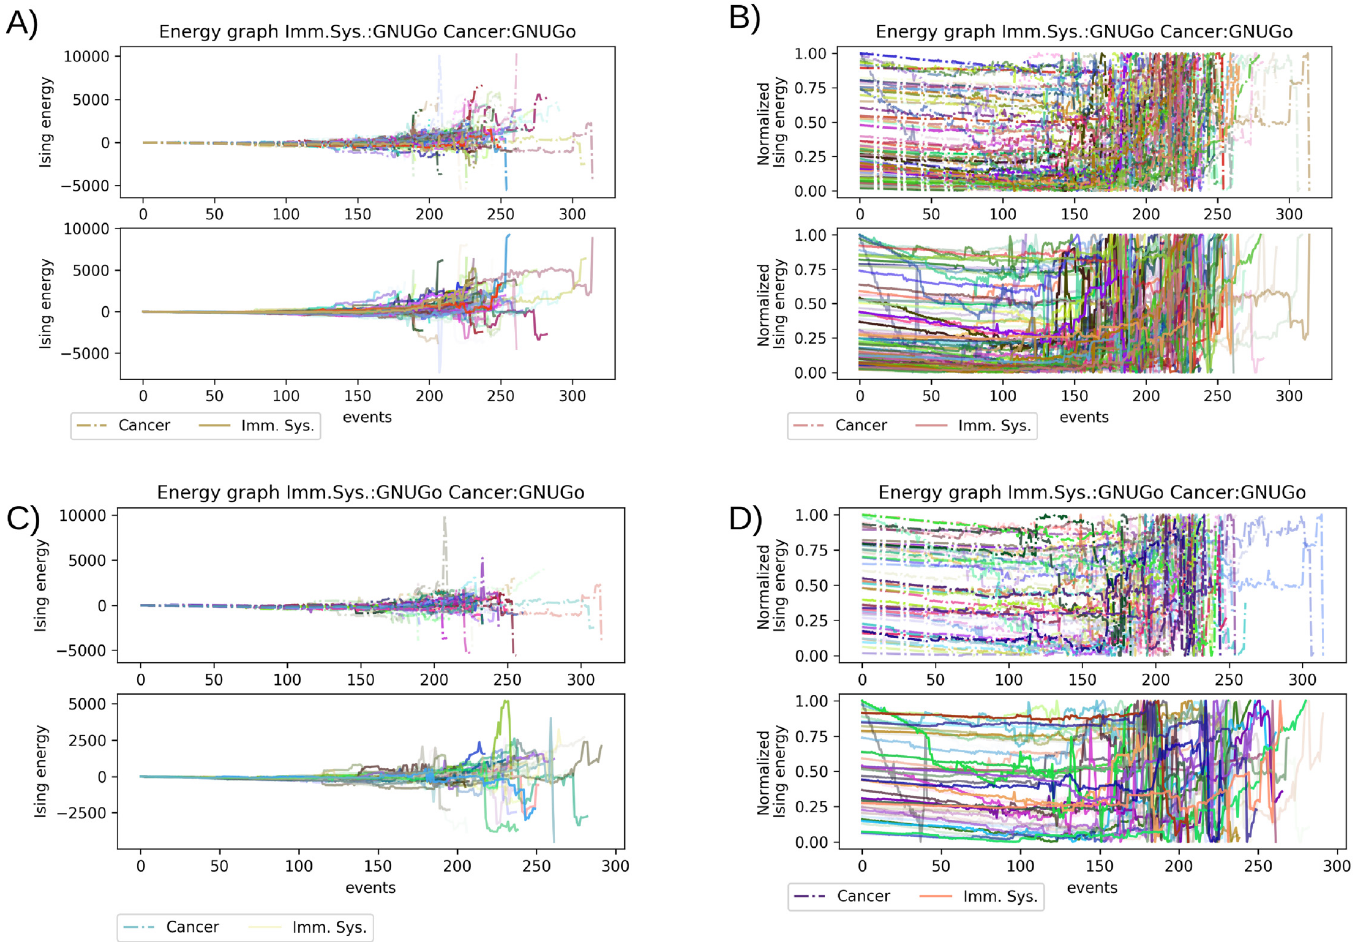
Fig 3. Comparison of the aggressive player vs passive player scenario. A) Plot of the Isign energy for all the simulations between GNUGo and MonteCarlo, upper panel correspond to cancer ells energy lower panel correspond to immune system energy. B) Normalized values of the simulations in the same order as